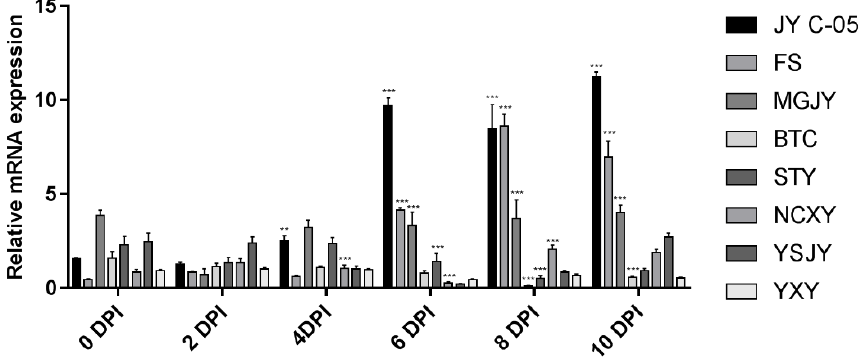
Figure 10. Relative expression levels of transcription factor RAP2-13. ** and *** indicated significant differences ( p < 0.05, respectively). BTC: ‘Bingtang’ sweet orange; STY: Pomelo; NCXY: Nanchuan citron; YSJY: Wild citron; YXY: Round citron; MGJY: American citron; FS: Finger Citron; JY C-05: Citron C-05.